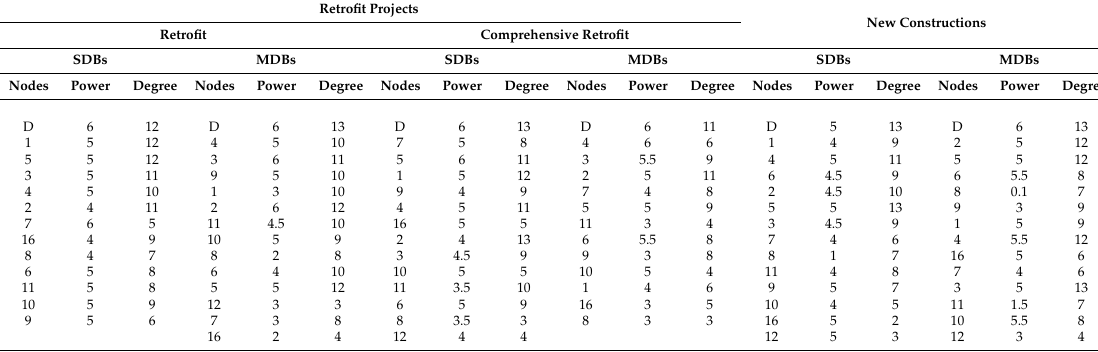
Table A6. Numerical output stakeholder networks classified according to building typologies and project types in Poland (PL).